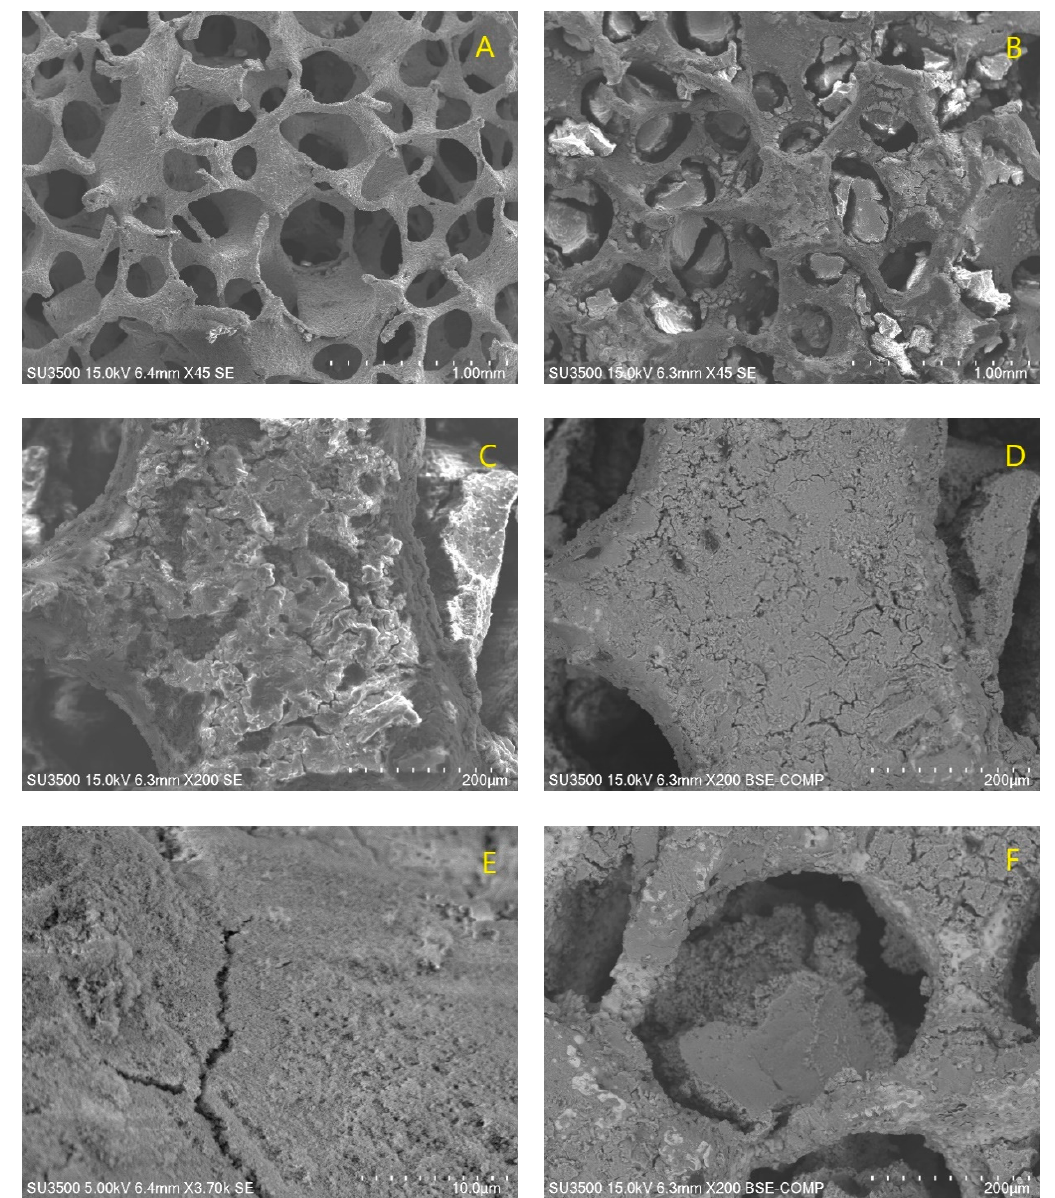
Figure 1. SEM image of the stainless-steel foam as received ( A ); SS with TiO 2 coating ( B ); SS with TiO 2 (at 200X) on the walls of foam channels, SE ( C ) and BSE ( D ); typical crack formed on the TiO 2 coating ( E ) and foam channel with TiO 2 clusters formed during the dip-coating ( F ).